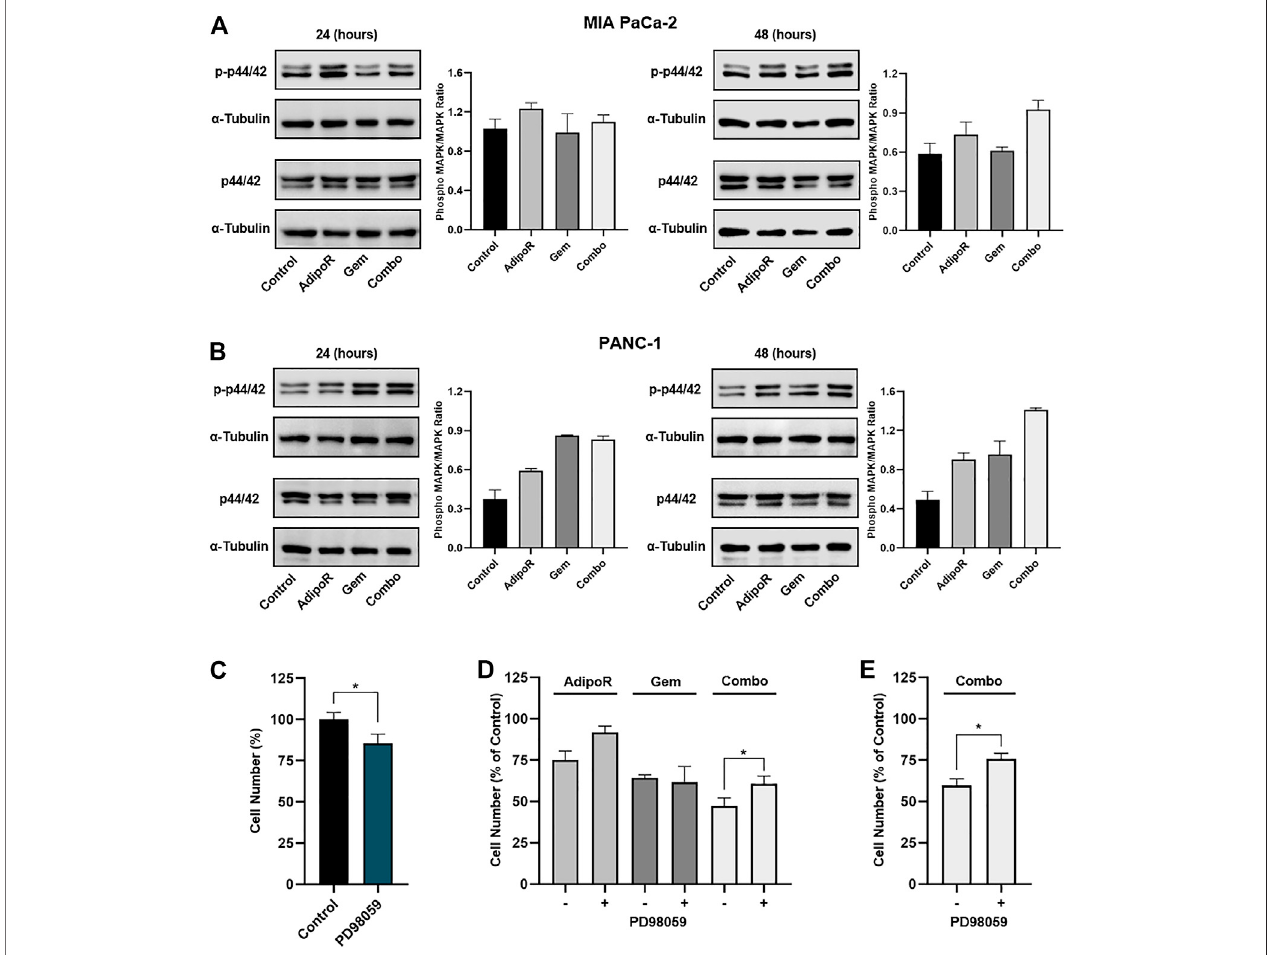
FIGURE 5 | Evaluation of p44/42 MAPK involvement in AdipoR plus Gem effects. MIA PaCa-2 (A) and PANC-1 (B) were treated and not (control) with 10 µg/ml AdipoR, 15 nM (MIA PaCa-2) or 50 nM (PANC-1) Gem, and AdipoR plus Gem over a period of 48 h. Thereafter, either single or combination consequences on p44/42 MAPKactivation(phosphorylation)wereestimatedbyWesternblotting.Phospho-MAPK/MAPKratioresultsfromthequotientofphospho-p44/42 MAPKanditsrelative housekeeping onthe geldividedby aquotient ofp44/42and its relative α -tubulin. (C) MIAPaCa-2 wasexposedand not (control) to10 μ M PD98059 for24 h, and the cell growth percentage was established. (D) MIA PaCa-2 single and combination treatments in MAPK-pro fi cient and -hampered background. (E) Combination treatments containing 10 µg/ml AdipoR plus 50 nM Gem were carried out in PANC-1 cells with or without PD98059 inhibitor. Two hours of PD98059 pretreatment preceded and not individual and combinatoryadministration. Results are depicted inpercentage asmean ±SD ofthree independent experiments. * p < 0.05 byTukey ’ s multiple comparisons or Student ’ s t-test.